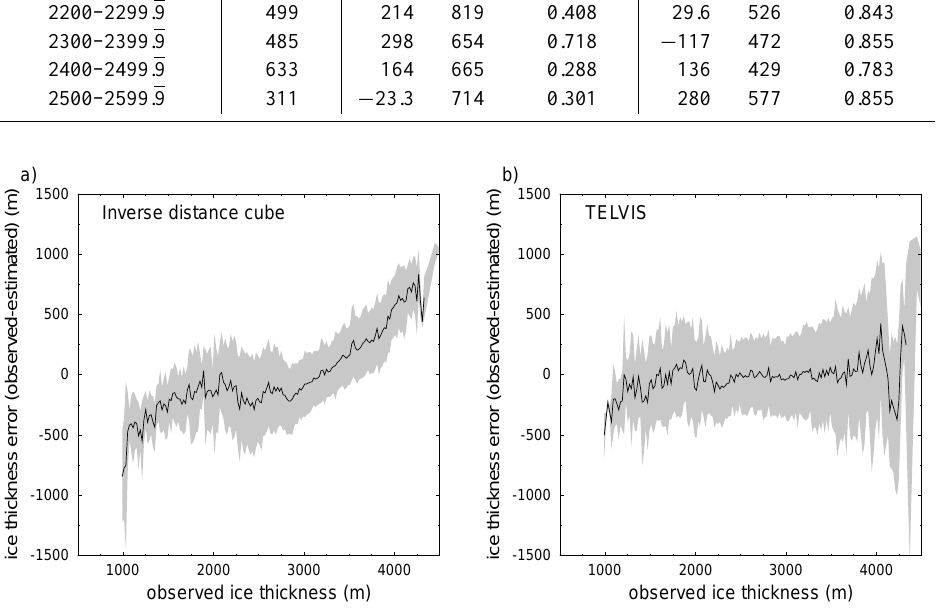
Fig. 6. Bias in ice thickness estimation, mean error (line) and standard deviation (shading) with a 90 km data exclusion zone, as a function of observed ice thickness for season one ICECAP data using (a) inverse distance cube and (b) TELVIS schemes. An ideal method would have a bias of zero across all depth scales, as approximated by the streamline method. The inverse-distance-cube method, in contrast, shows significant bias at both shallow and deep scales, as expected (see Sect. 3 for